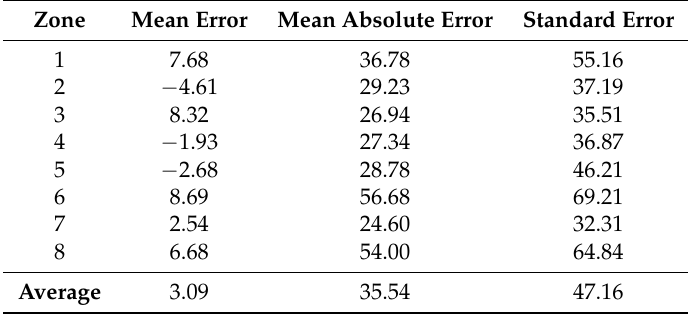
Table 3. Mean errors in the London instances